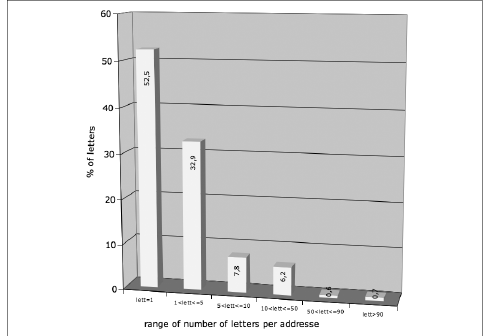
Fig. 10. Tacchini’s letters statistical